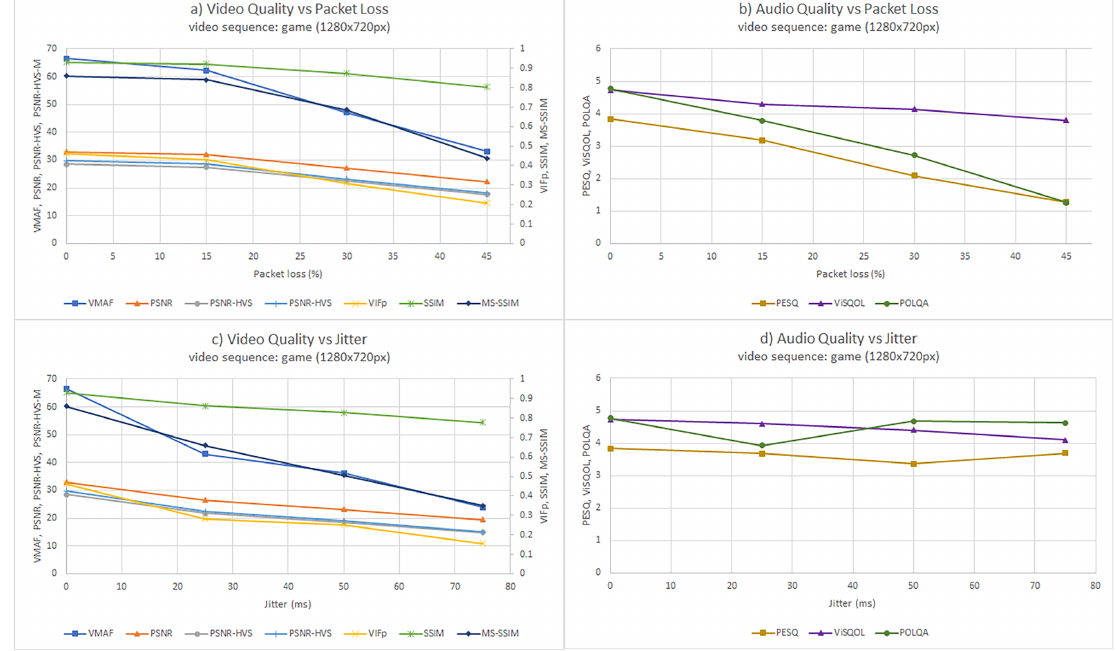
Figure 5. Objective results for the game sequence. ( a ) Video quality results using different scenarios of packet loss. ( b ) Audio quality results using different scenarios of packet loss. ( c ) Video quality results using different scenarios of jitter. ( d ) Audio quality results using different scenarios of